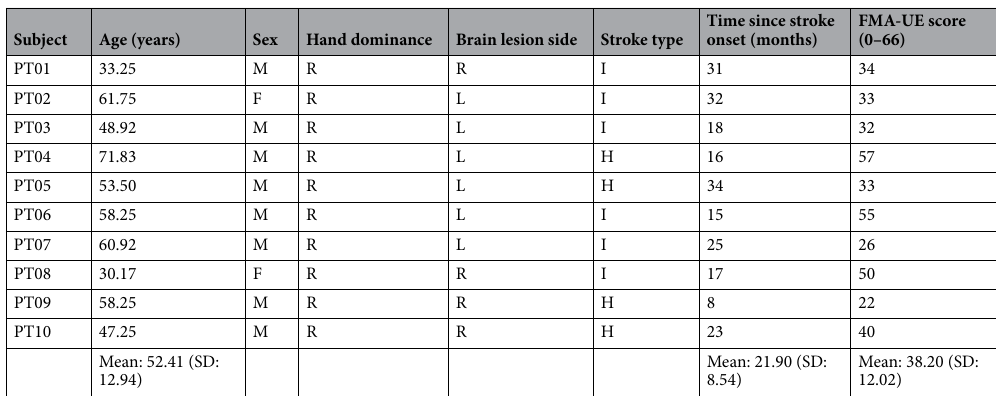
Table 2. The demographic and clinical characteristics of the patients with stroke. Abbreviations: F, female; FMA-UE, Fugl-Meyer Assessment of the Upper Extremity; H, hemorrhagic; I, ischemic; L, left; M, male; R, right; SD, standard deviation. Note: Higher FMA-UE scores are indicative of less upper-extremity motor